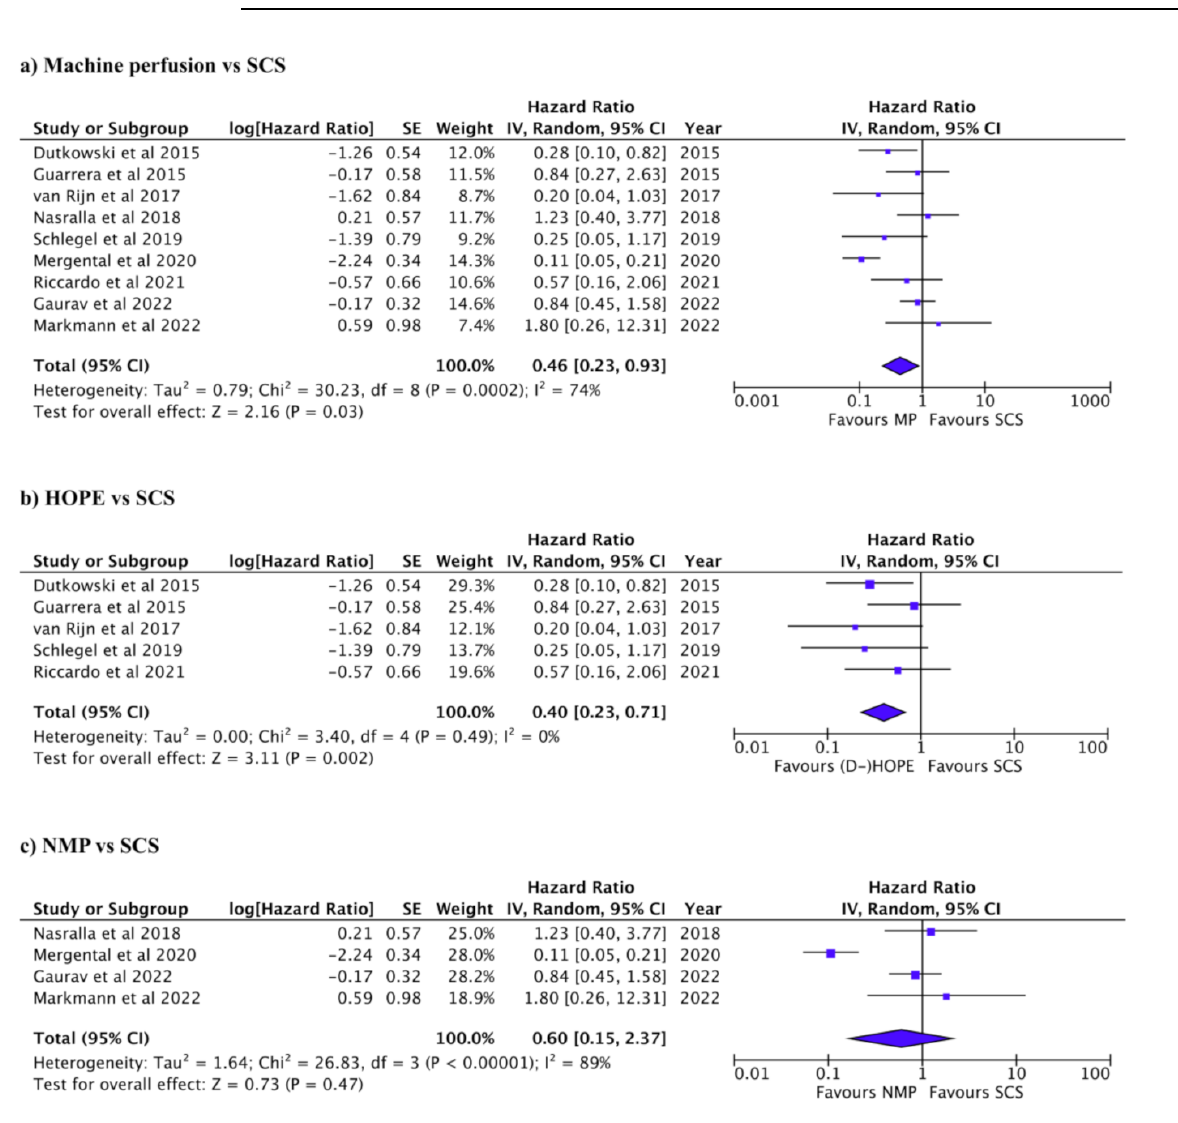
Figure 5. Forest plots for graft survival. ( a ) Machine perfusion (hypothermic or normothermic) vs. SCS ( P = 0.03). ( b ) HOPE vs. SCS ( P = 0.02). ( c ) NMP vs. SCS ( P =